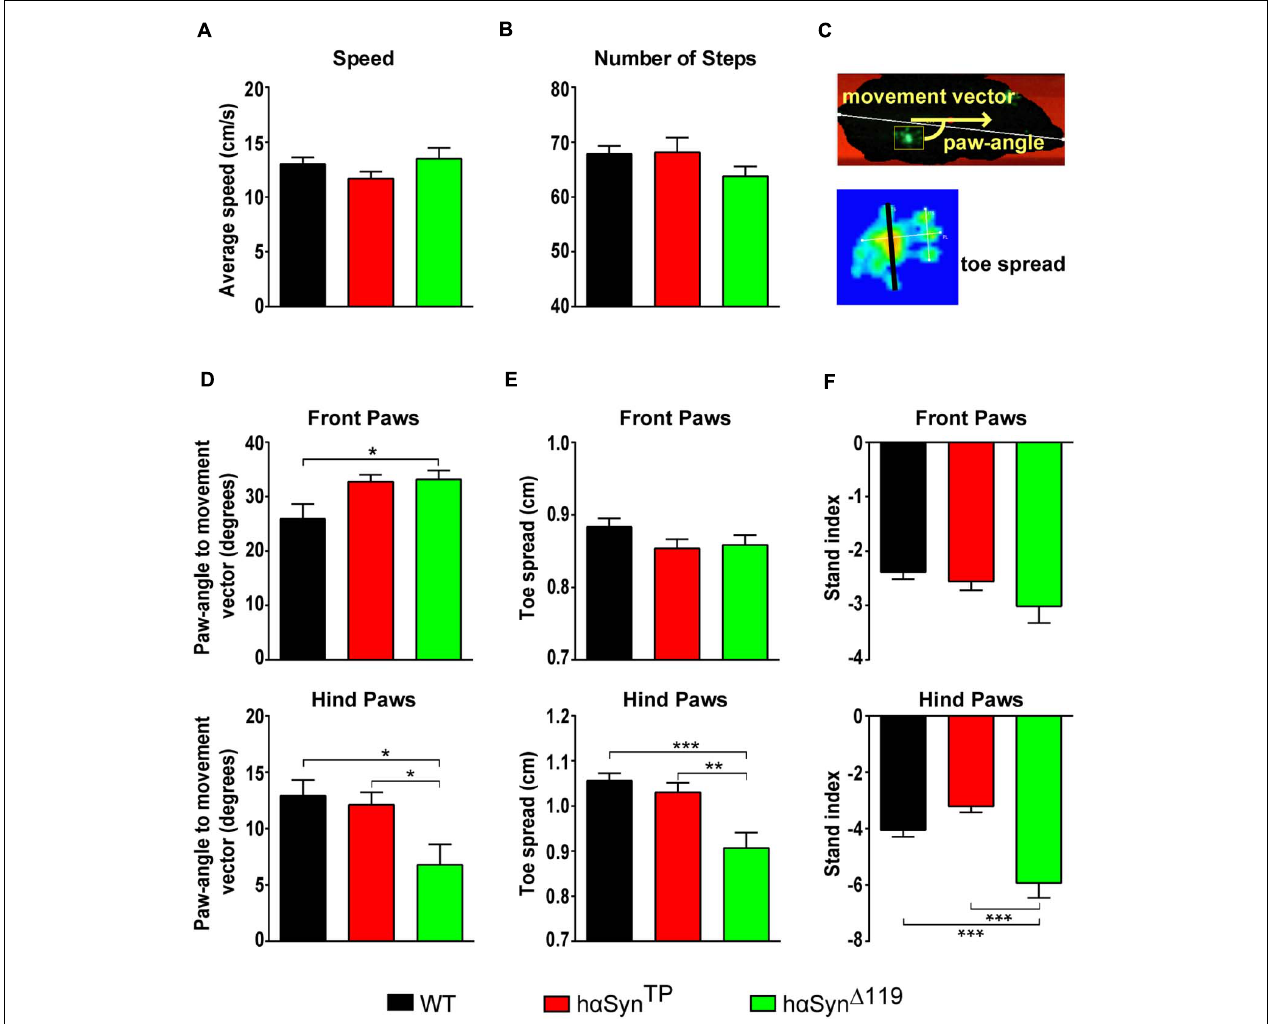
FIGURE 5 | Deviant gait patterns in h α Syn TP and h α Syn (cid:49) 119 mice at 1.5 years of age. (A,B) Gait analysis using the CatWalk system in WT, h α Syn TP , and h α Syn (cid:49) 119 mice showed no significant difference in their walking speed (A) or the number of steps (B) . (C) Diagram illustrating the “paw-angle to movement vector” and the toe spread (black line between toes 1 and 5). (D–F) Comparison of paw-angle, toe spread and stand index for front (top graphs) and hind paws (bottom graphs) for the various genotypes. Values represent mean ± SEM. Group comparisons using 1-way ANOVA with Tukey’s multiple comparisons test. * p < 0.05, ** p < 0.01, and *** p <